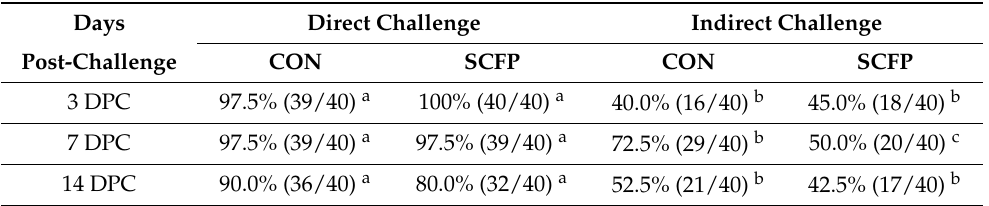
Table 3. Prevalence and number of SE-positive ceca in pullets directly challenged and indirectly exposed to the challenge strain of SE.